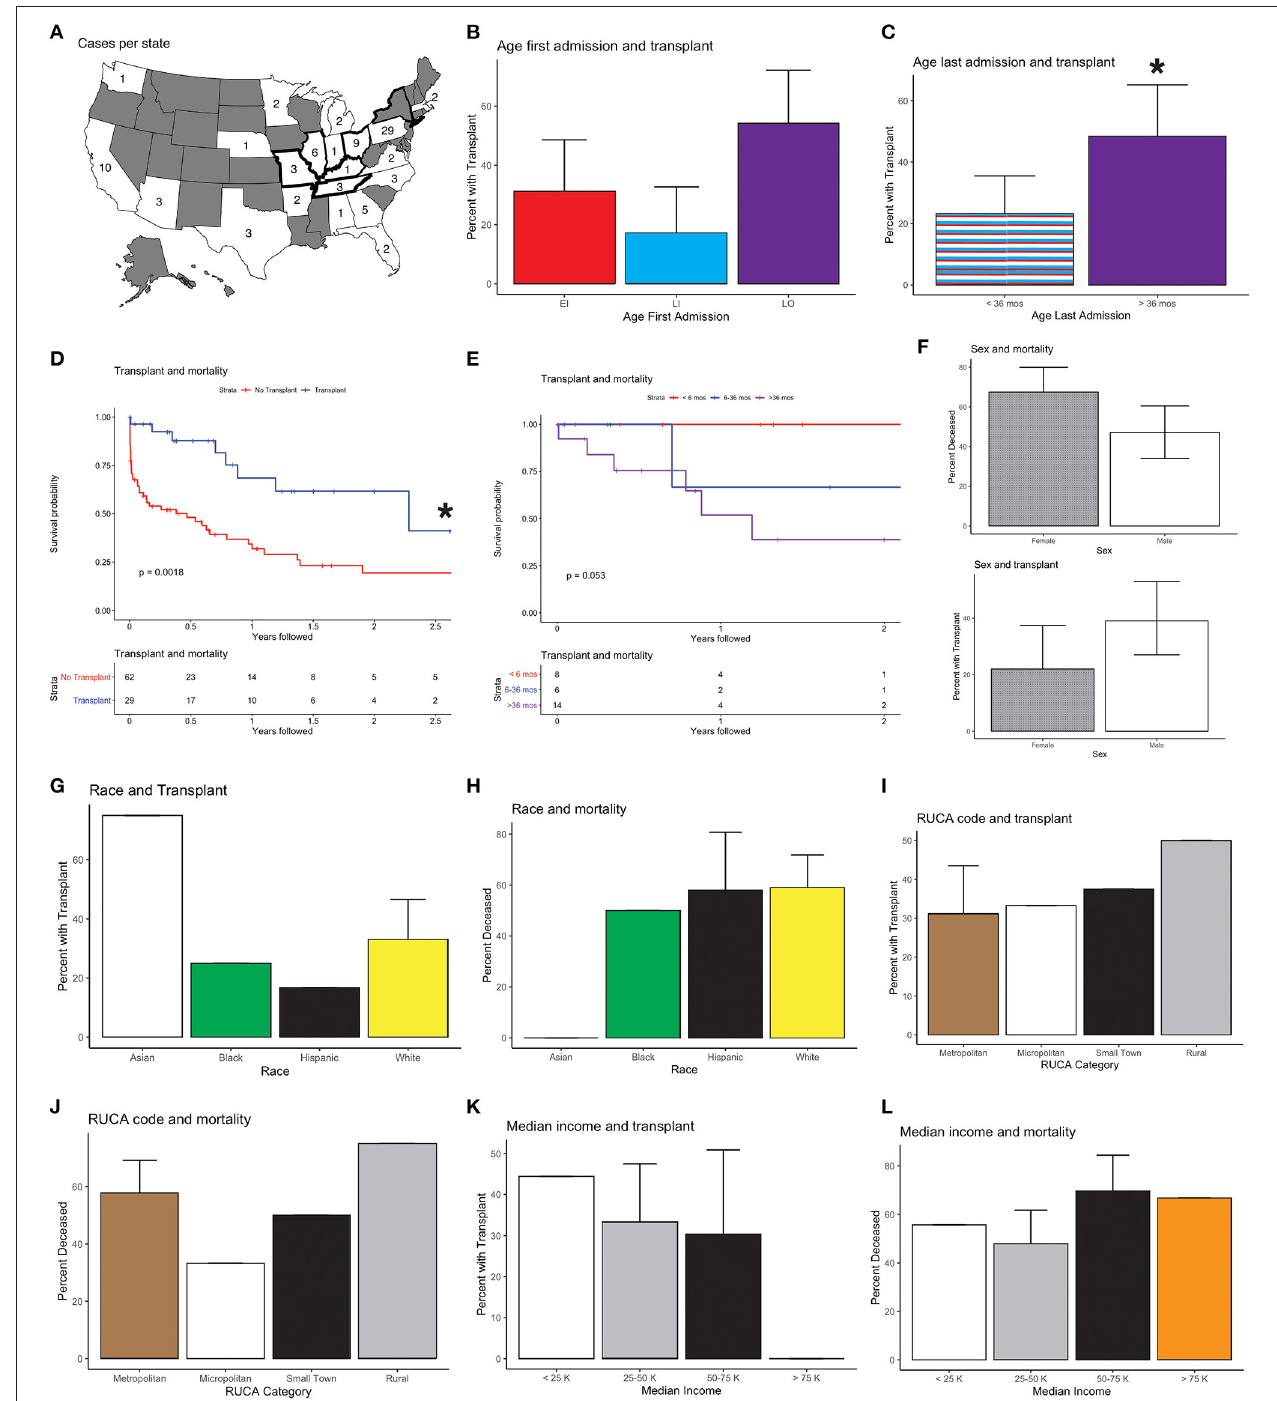
FIGURE 1 | National Krabbe disease (KD) data and outcomes; 95% confidence intervals are shown. (A) Cases per state. Bolded outlines denote states with KD on their newborn screening panel during the study period. (B) Age at first admission and transplant (HSCT) status. Age at first admission was correlated with receiving HSCT, with patients who presented after 36 months being more likely to receive HSCT than individuals who first presented between 6 and 36 months of life ( p < 0.02). All other comparisons, EI vs. LI and EI vs. LO, were not significant ( p > 0.1). (C) Age of last admission and HSCT status. Age at last admission > 36 months was associated with HSCT ( p < 0.03). (D) Kaplan-Meier survival curves of mortality and HSCT. Mortality and absence of HSCT were correlated ( p < 0.01). (E) Mortality and age of HSCT. One hundred percent ( N = 8) of individuals who received HSCT prior to 6 months, 67% ( N = 4) of individuals who received transplant between